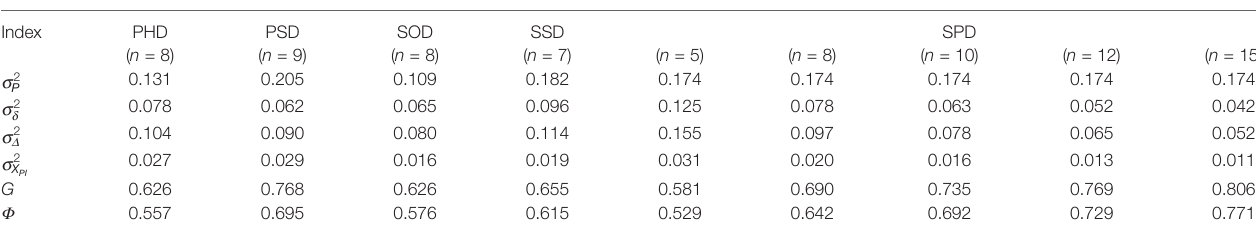
TABLE 5 | P (cid:129) × I ° - designed D-study results of the various domains of QLICP-BR